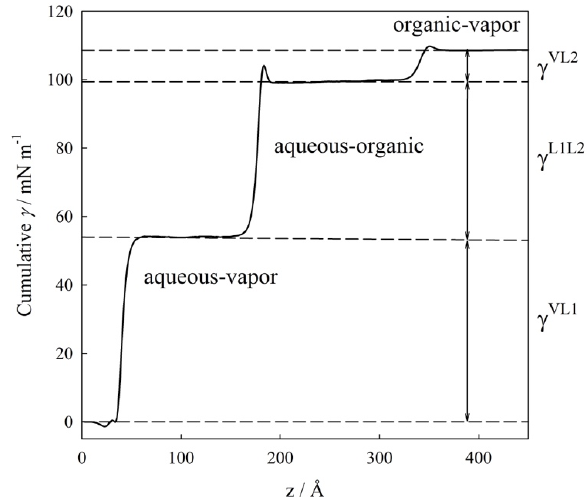
Figure 3. Cumulative interfacial tension, γ , as a function of the z coordinate for water (1) + n -hexane (2) mixture at the isothermal three-phase condition of 380 K. γ VL1 ≈ 54.03 mN/m, γ L1L2 ≈ (99.44 – 54.03) mN/m ≈ 46.41 mN/m, and γ VL2 ≈ (108.56 – 99.44) mN/m ≈ 9.12 mN/m.